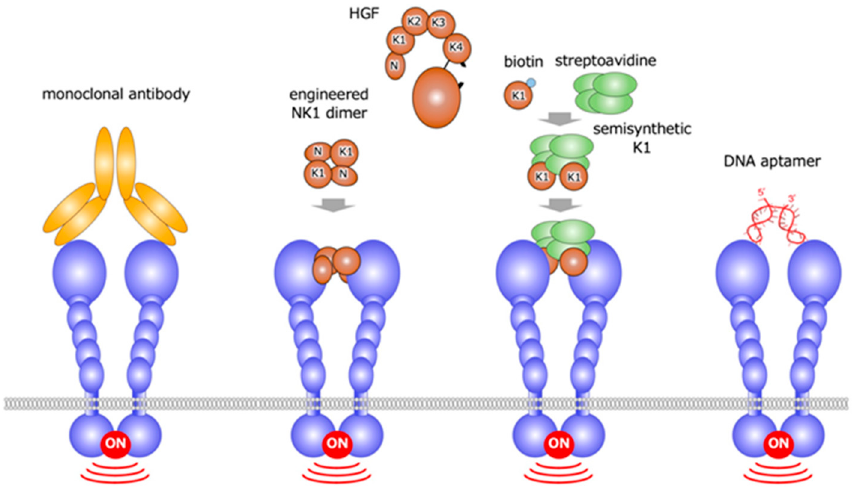
Figure 10. HGF-mimetic (MET-agonistic) molecules created by different approaches: monoclonal antibodies, engineered NK1, semisynthetic K1, and DNA aptamer.